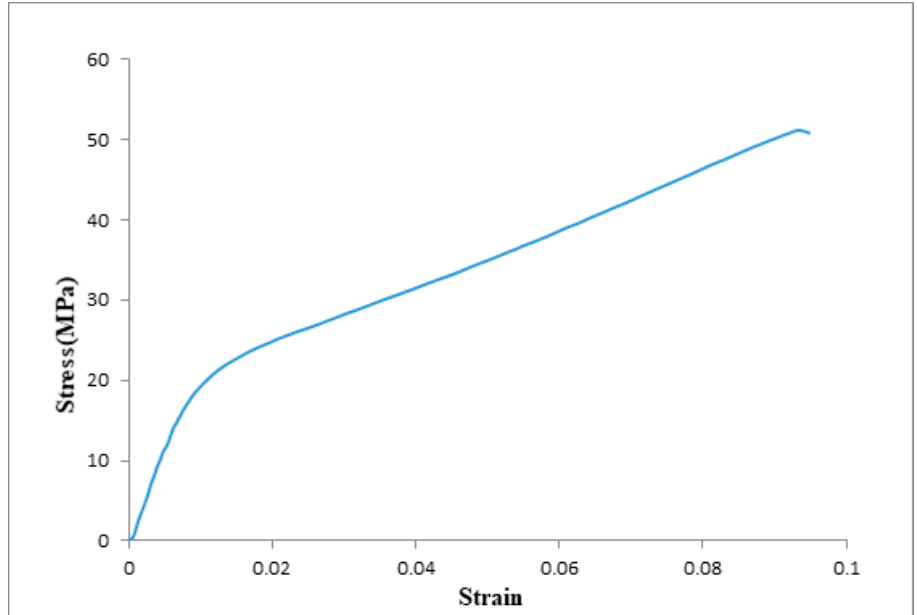
Figure 5. The stress–strain curve for PA-TFC reverse osmosis membrane. Table 1. Mechanical properties of polyamide membrane.